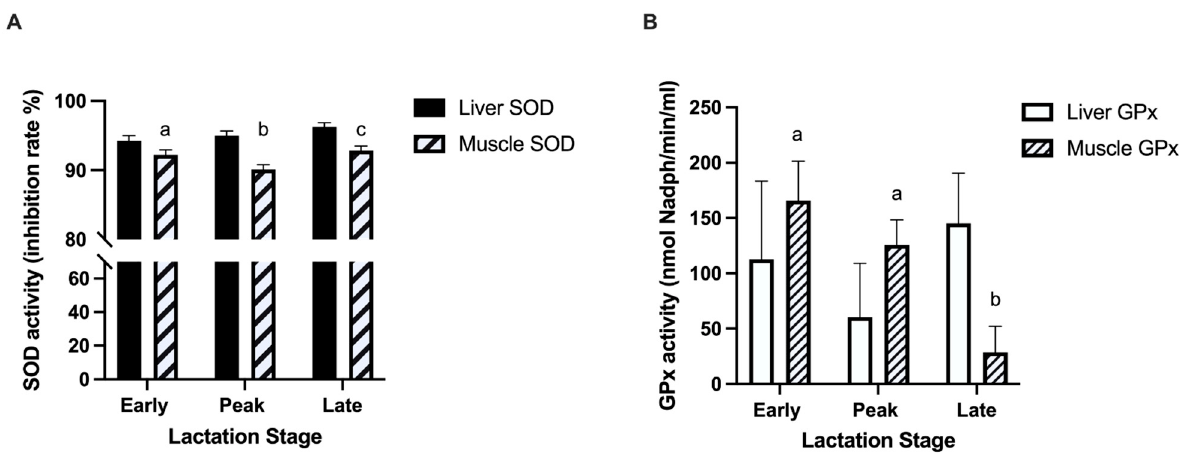
Figure 3. Antioxidant activity in liver and skeletal muscle across lactation. Antioxidant activity of ( A ) superoxide dismutase (SOD) and ( B ) glutathione peroxidase (GPx) were measured at early (8 ± 2 DIM), peak (75 ± 4 DIM), and late (199 ± 6 DIM) lactation from 11 multiparous Holsteins per timepoint. Disparate letters above bars represent significant differences between lactation stages for antioxidant activity in skeletal muscle tissue ( p < 0.05).